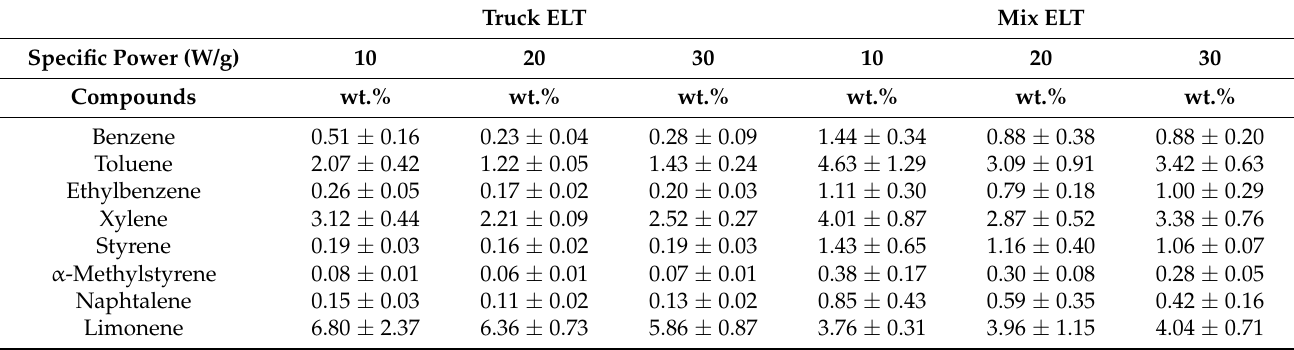
Table 4. Major compounds identified in oil samples (wt.